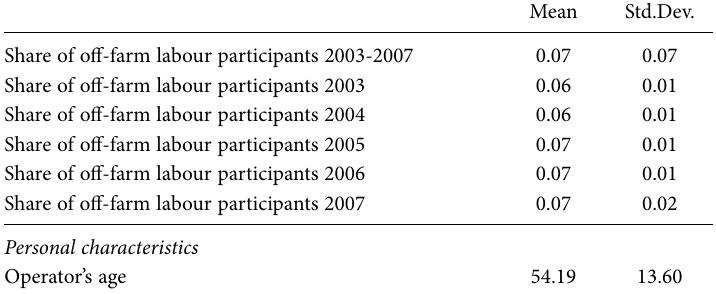
Table 1. Descriptive statistics of the variables (2004-7 unless otherwise